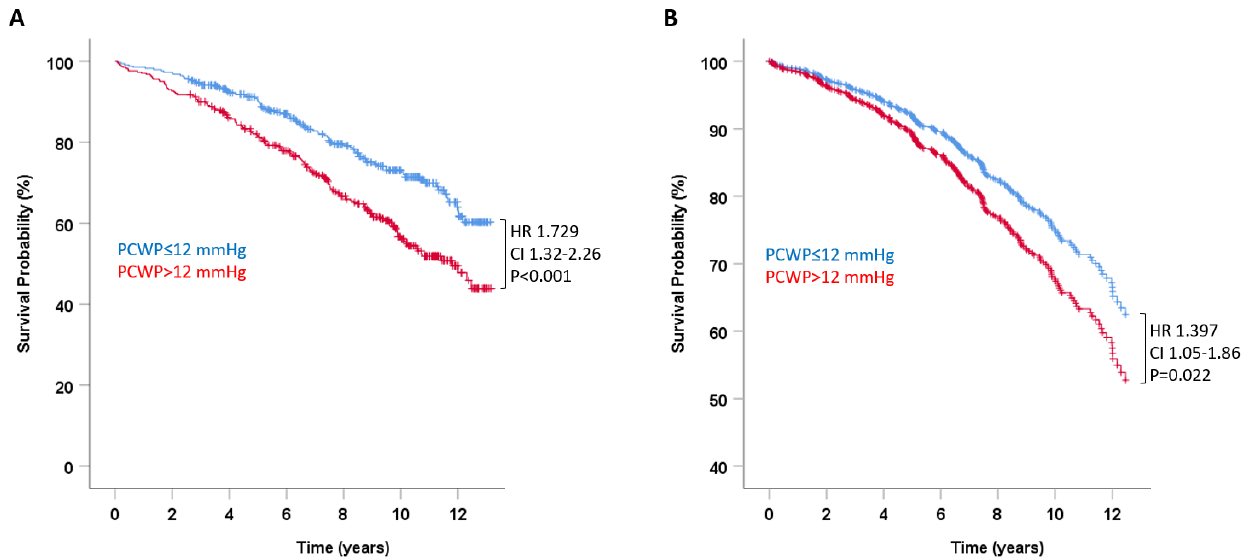
Figure 2. Pulmonary capillary wedge pressures at rest and survival in heart failure. Survival probability in patients with normal (≤12 mmHg) and elevated (>12 mmHg) pulmonary capillary wedge pressure (PCWP) at rest unadjusted ( A ) and adjusted for clinical and echocardiographic variables that predicted mortality in univariate analysis (see Table 1) ( B ).